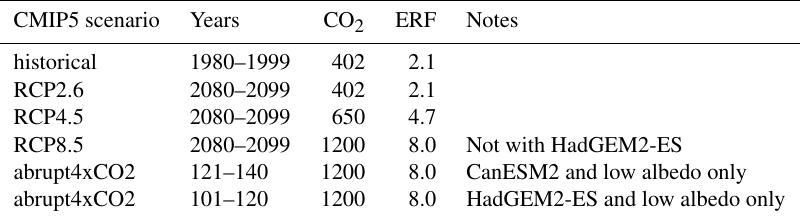
Table 2. AOGCM climates used to supply sea surface boundary conditions for the first set of FiG experiments. The BCs mostly determine the climate, with only a relatively small influence from the CO 2 concentration (in ppm). This is “equivalent CO 2 ”, chosen for RCP4.5 and RCP8.5 to give approximately the nominal effective radiative forcing (ERF) in RCPs in 2100 (Wm − 2 ), with all other forcing agents kept as pre-industrial. For simplicity, regarding 1980–1999 as “present day”, we decided to use the same concentration for historical and RCP2.6 simulations. We consider this acceptable because the AR5 median assessment of the net anthropogenic ERF in 2011 is 2.3Wm − 2 , with a likely range of 1.1–3.3Wm − 2 , and the difference between this and the nominal forcing of 2.6Wm − 2 under RCP2.6 in 2100 is small compared with the large systematic uncertainty. Similarly for simplicity we used the same CO 2 concentration for RCP8.5 and abrupt4xCO2. CMIP5 scenario Years CO 2